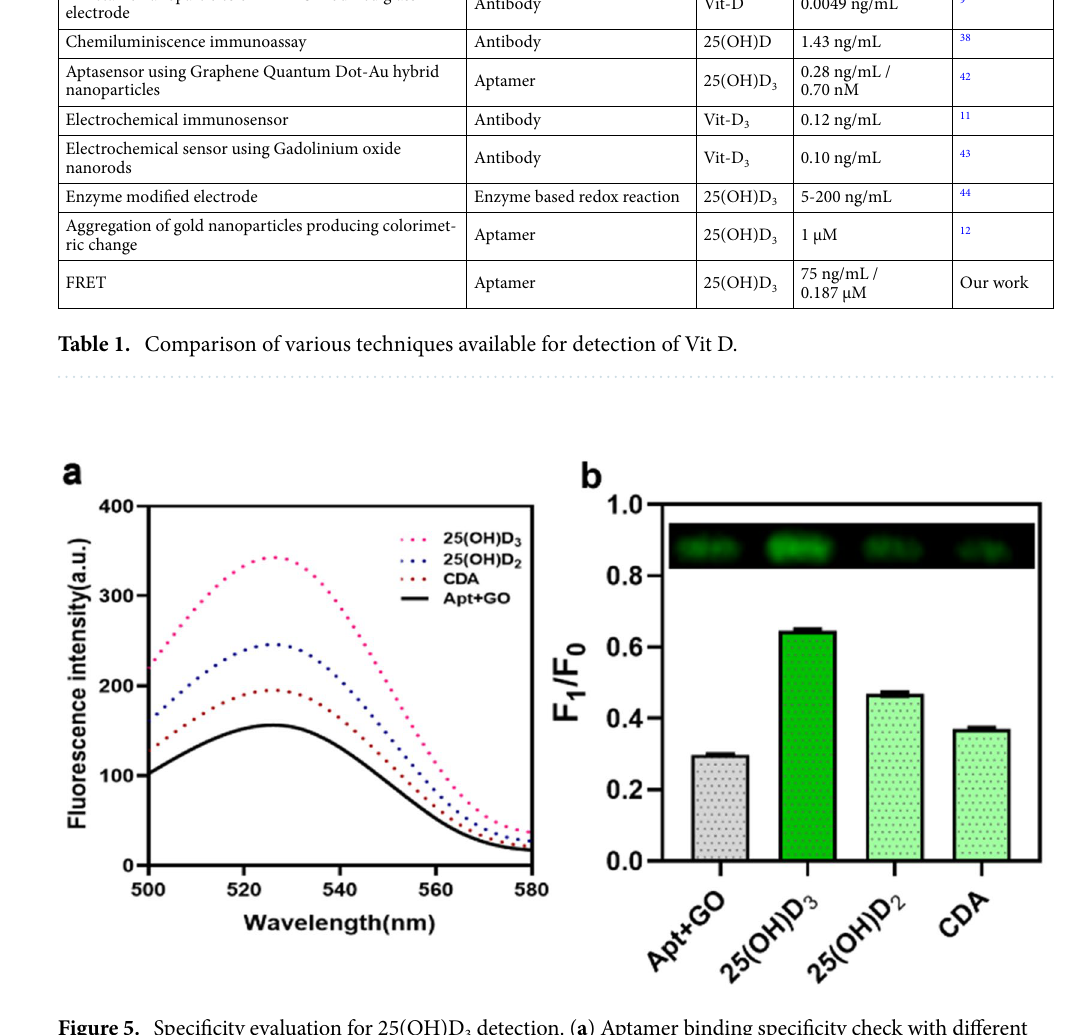
Figure 5. Specificity evaluation for 25(OH)D 3 detection. ( a ) Aptamer binding specificity check with different negative controls